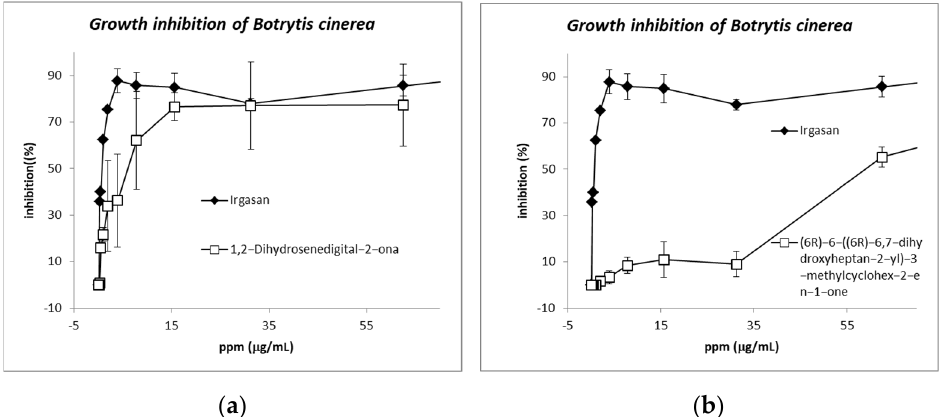
Figure 8. Data obtained from the antifungal test of the isolated compounds 1,2-dihydrosenedigital-2-ona ( 10 ) and (6 R )-6-((6 R )-6,7-dihydroxyheptan-2-yl)-3-methylcyclohex-2-en-1-one ( 11 ) from Baccharis sp. Comparison of the activities: ( a ) compound 10 and ( b ) compound 11 , showing completely different activities (IC50 of 3.1 ppm and 59.1 ppm, respectively).